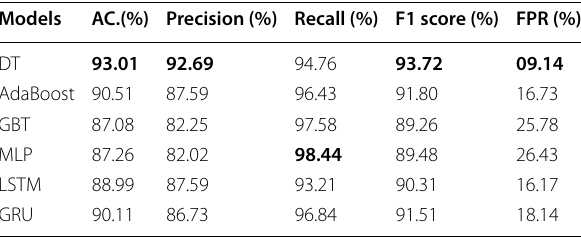
Table 8 Result of the models with selected features (10)